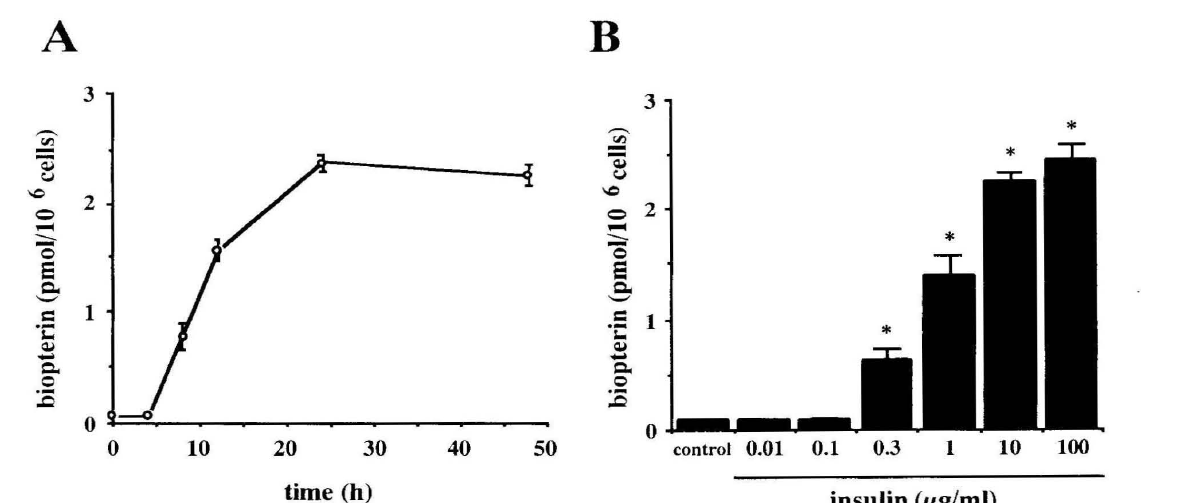
Figure 1. EfJect of insulin on intracellular BH4 conrent in endothelial cells. A; Cells were incubated with insulin (10 /-lg/ml) for various periods. B; Cells were incubated with insulin (0.01-100 /-lg/ml) for 24 h. Results are the means = S.E.M. of 10-22 assays. *Signitlcant change in comparison to control group (p< 0.05). Pteridines / Vol. 10 /